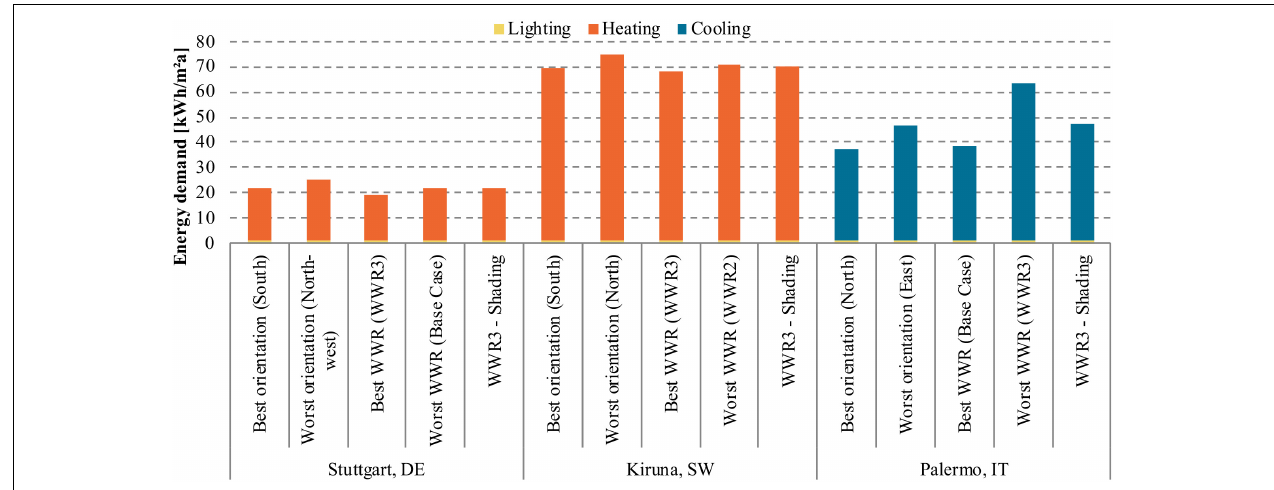
FIGURE 1 | Heating, cooling and electricity for lighting demand due to variations of the building orientation and window to wall ratio in the three assessed climate regions.